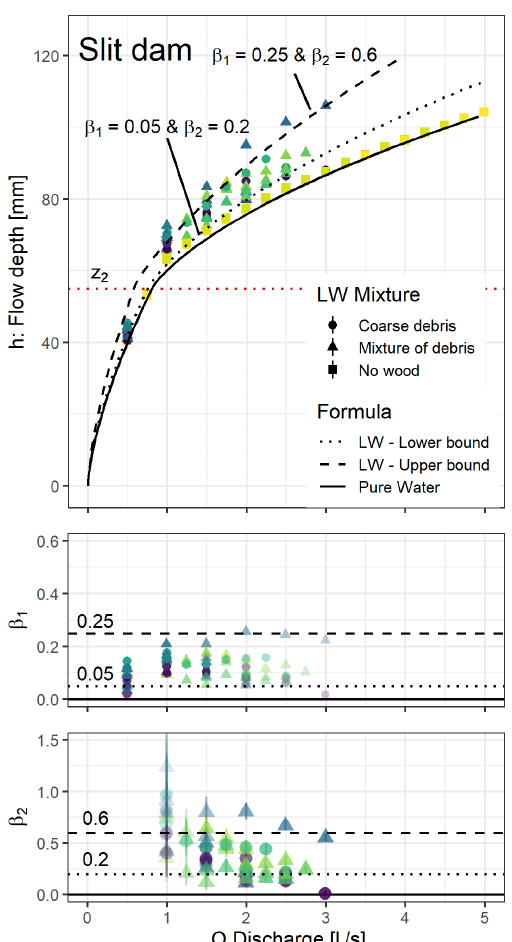
Figure 8. Flow depth versus discharge for slot dam and back- calculated β 1 and β 2 values; each colour shade corresponds to a different